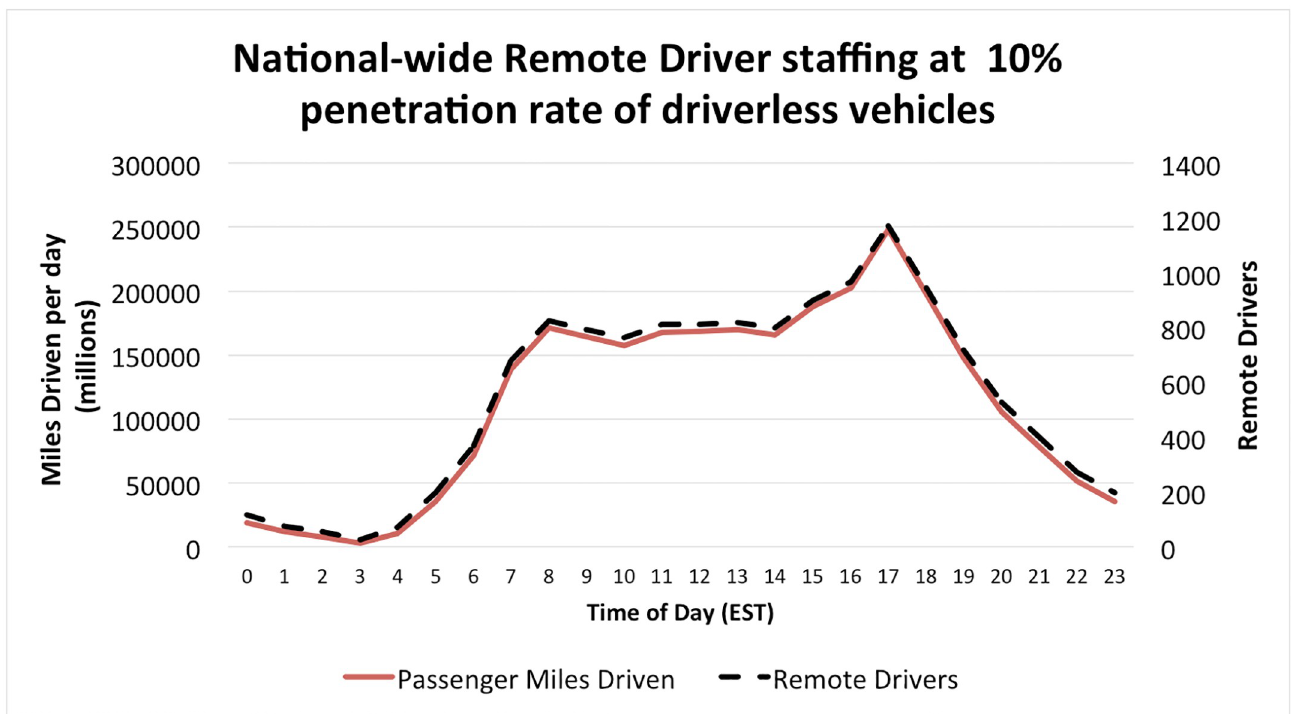
Fig 2. Estimated number of remote drivers needed across the United States. Calculated by time of day in the Erlang-B model. All times normalized to Eastern Standard Time.